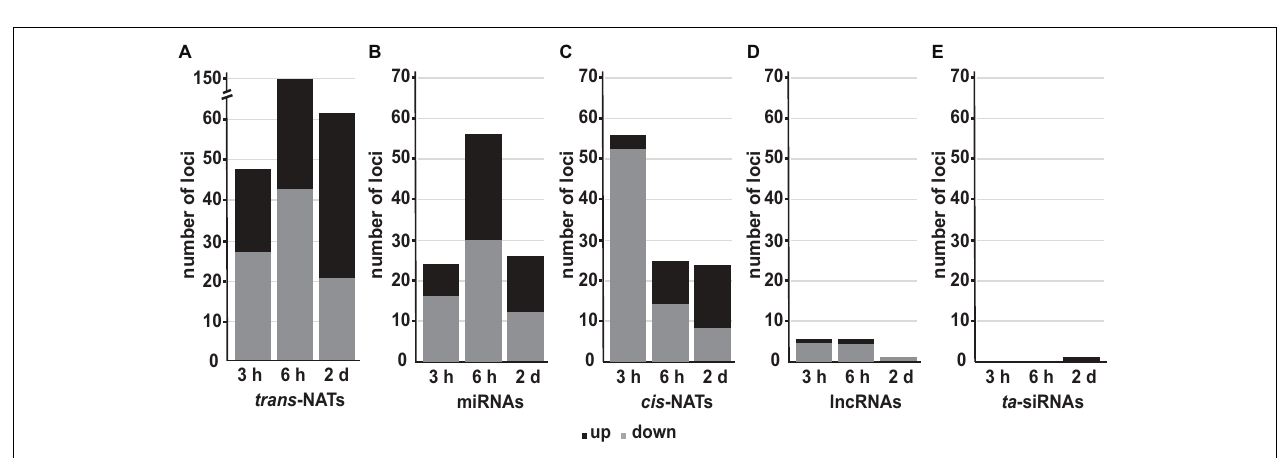
FIGURE 1 | The size distribution (20–24 nt) of mapped sRNAs after 3 h (A) , 6 h (B) and 2 days (C) of high light treatment (represented in reads per million). The distribution of trimmed ncRNA reads from different RNA classes (reads per million) in untreated and high light acclimated samples (D) .